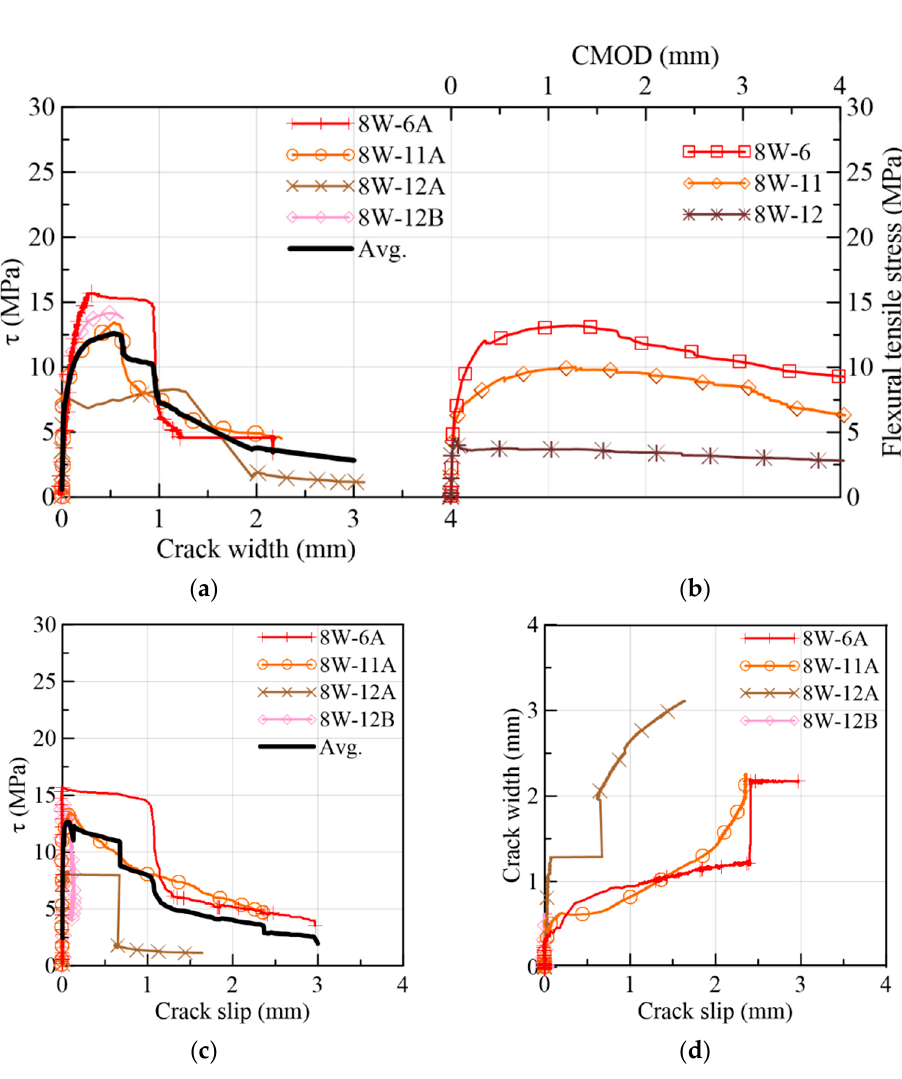
Figure 12. Mechanical results of 8W specimens: ( a ) shear stress vs. crack width; ( b ) flexural tensile stress vs. CMOD; ( c ) shear stress vs. slip; ( d ) crack width vs. slip.